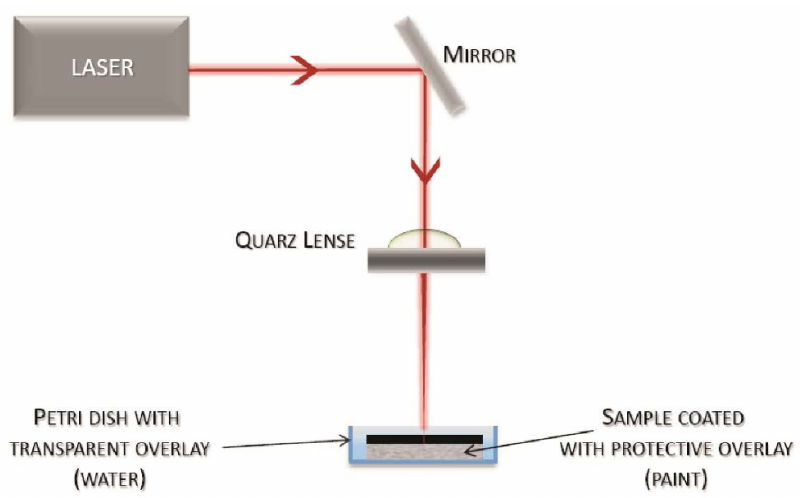
Figure 1. The experimental setup for laser shock